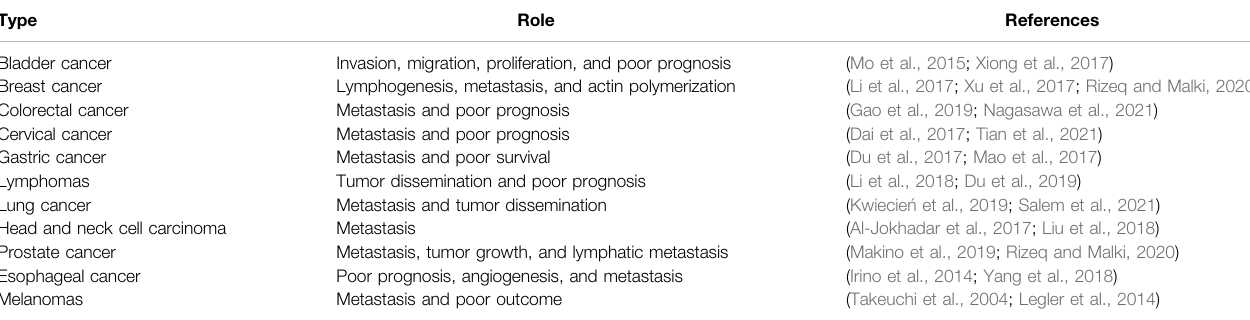
TABLE 1 | Involvement of CCR7 in different human